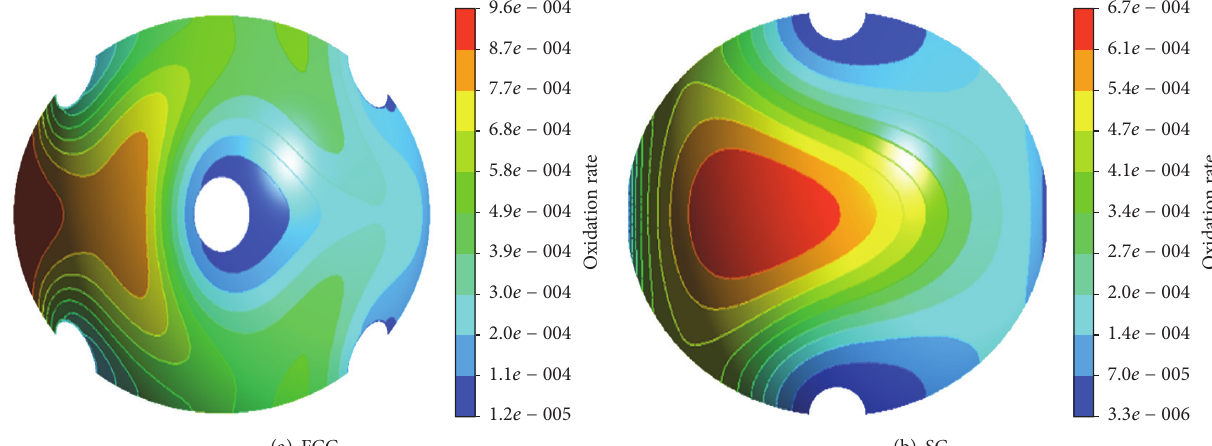
Figure 11: Distribution of oxidation rate with different model.